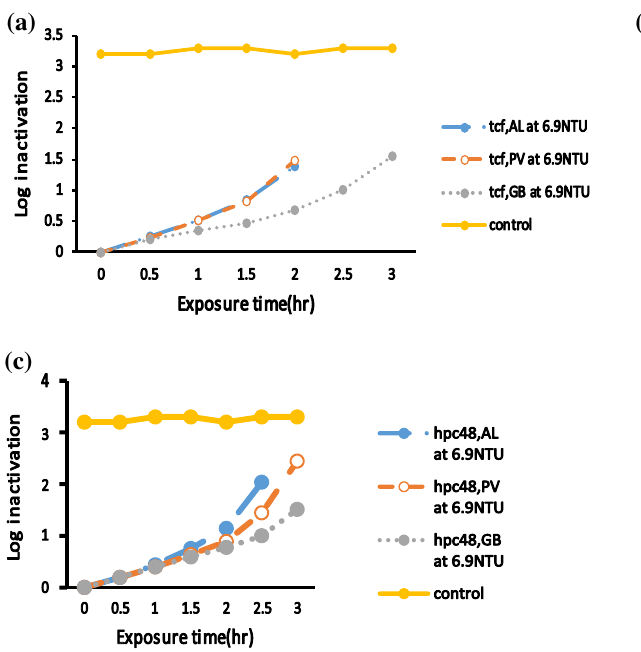
Fig. 5 Comparison of microbial inactivation between concentrators at 6.9 NTU turbidity level. a Comparison between concentrators for total coliform counts inactivation. b Comparison between concentra-